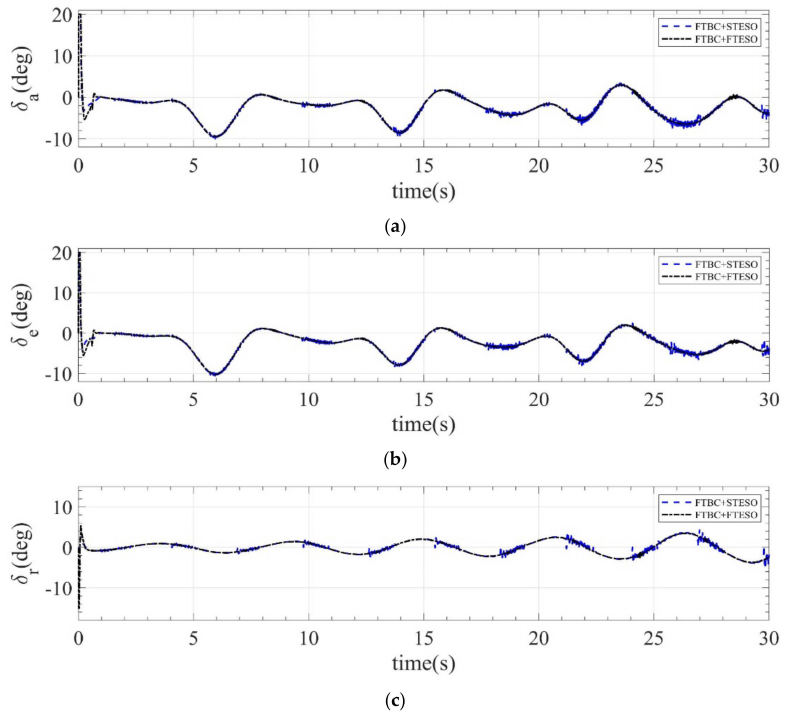
Figure 9. ( a ) Control input curve of δ a , ( b ) control input curve of δ e , and ( c ) control input curve of δ r